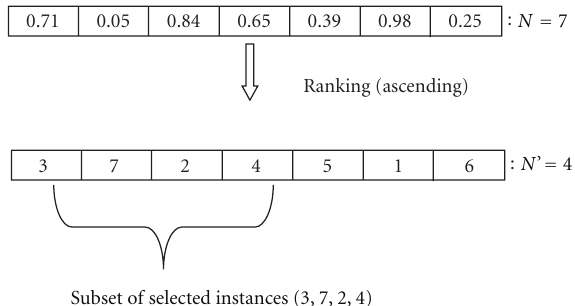
Figure 3: From a particle in [0,1] N + n search space to a subset of instances and features.